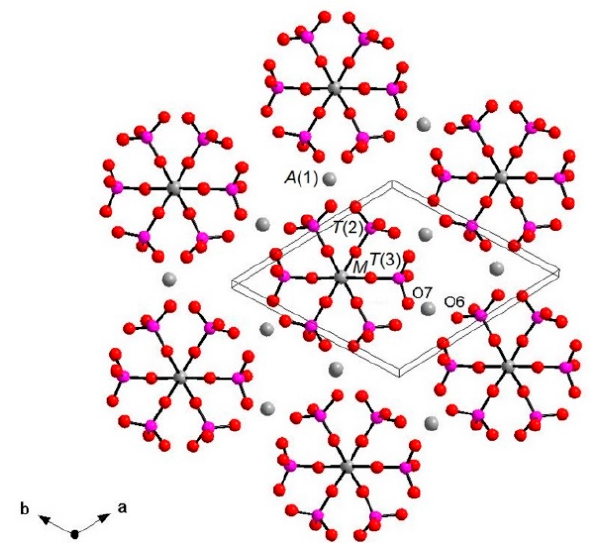
Figure 6. Layer perpendicular to c showing [ M (PO 4 ) 6 ] pinwheel units [32]. A (2), A (3) and X sites omitted for clarity. A (1)-O, A (2)-O, A (3)-O and X-O bonds omitted for clarity.